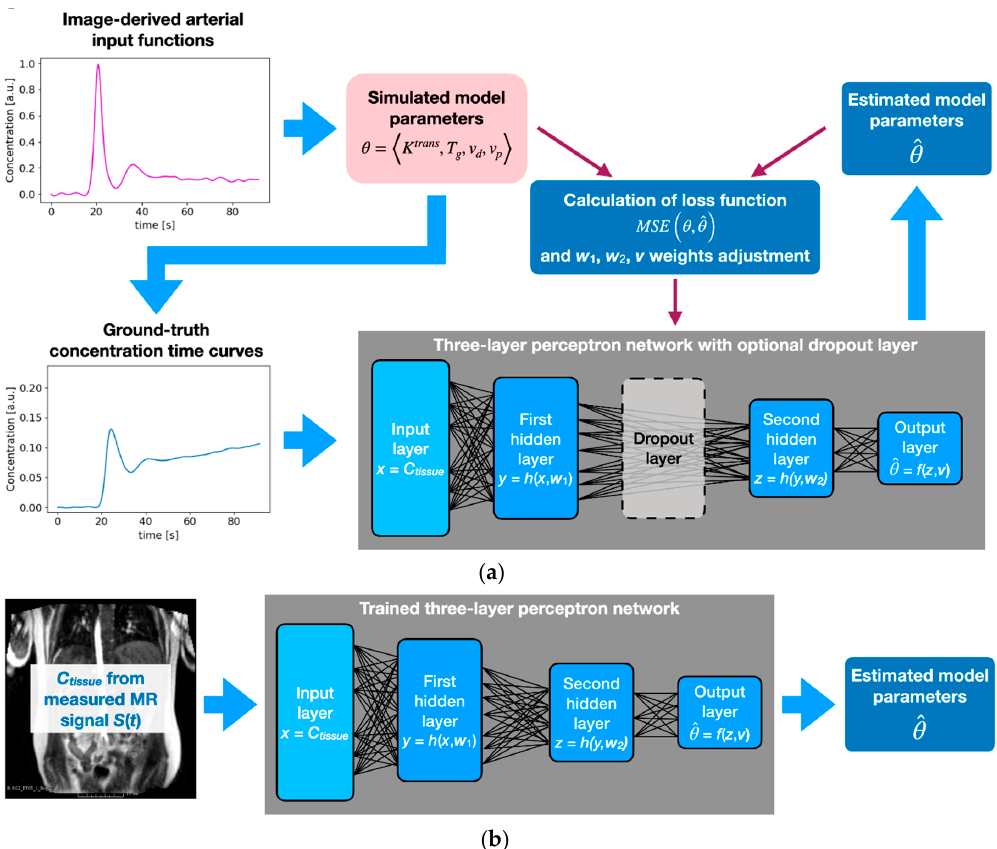
Figure 3. Overview of a pharmacokinetic (PK) model parameter fitting using an artificial neural network operating in the training ( a ) and recall ( b ) modes. The three-layer perceptron structure is shown only conceptually—the number of hidden units was adjusted during the network design process. The number of output units was always set to 4, i.e., the number of PK model parameters. All layers are fully connected, as in the conventional multi-layer perceptron (MLP) structures, except dropout mechanism was switched on, in which case random connections between hidden layers were removed during training to prevent network overfitting.